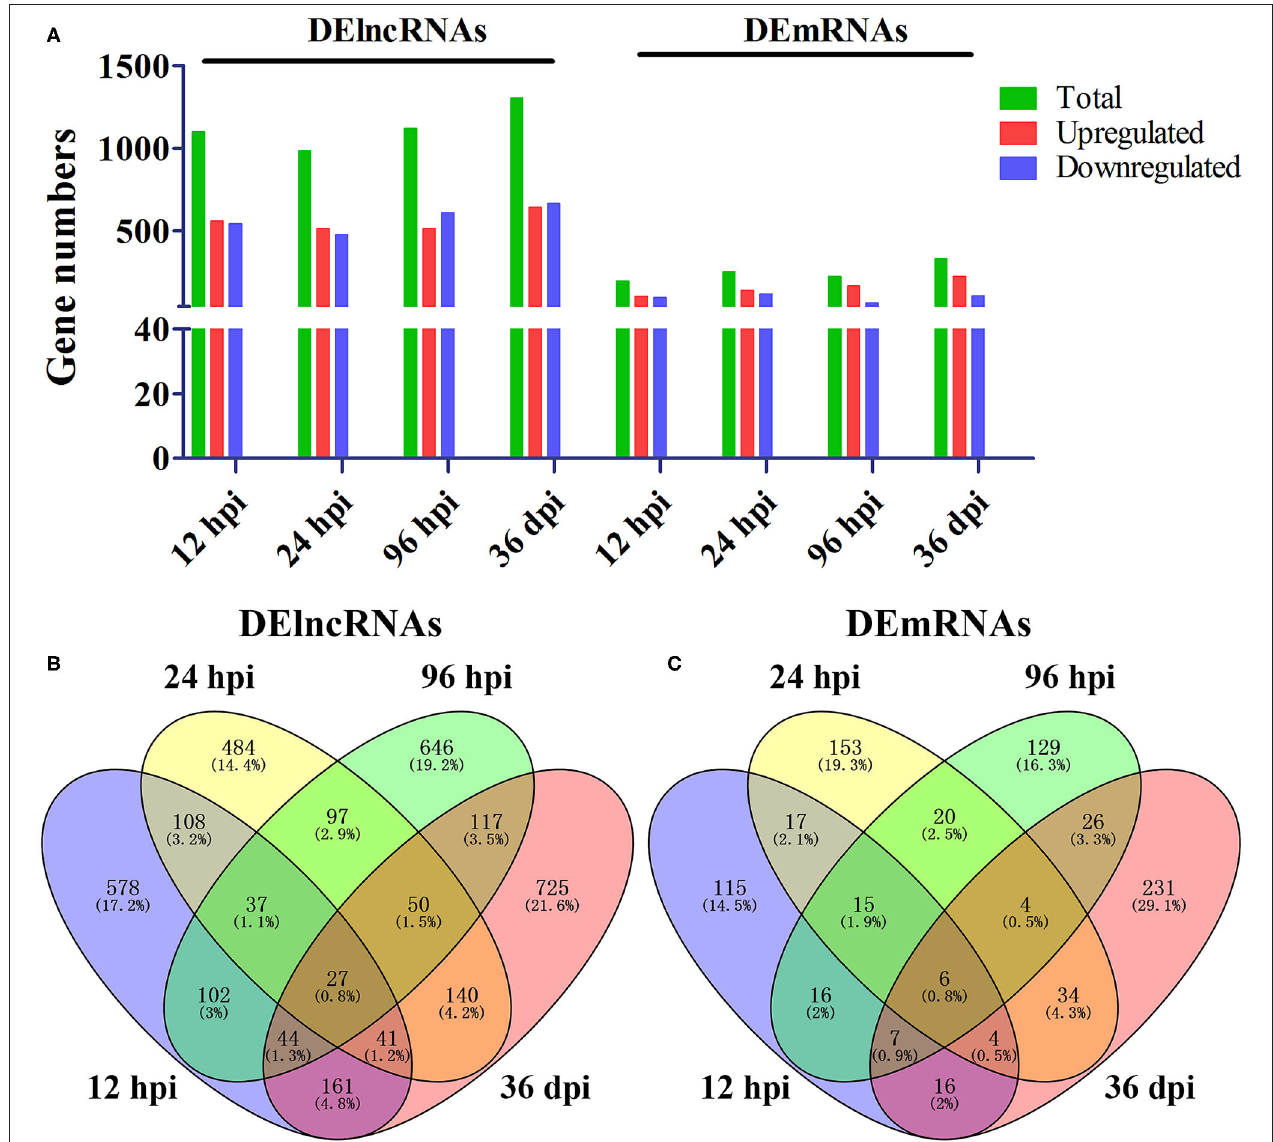
FIGURE 3 | Comparisons of differentially expressed lncRNAs and mRNAs in the bone marrow of Beagle dogs infected by Toxocara canis at 12h post-infection (hpi), 24 hpi, 96 hpi, and 36 day post-infection (dpi). (A) The number of DElncRNAs and DEmRNAs at four infection stages. Green, red, and blue colors represent the number of total, upregulated, and downregulated transcripts, respectively. (B,C) Venn diagrams showing the common and unique DElncRNAs and DEmRNAs at the four indicated time points after infection between infected and control